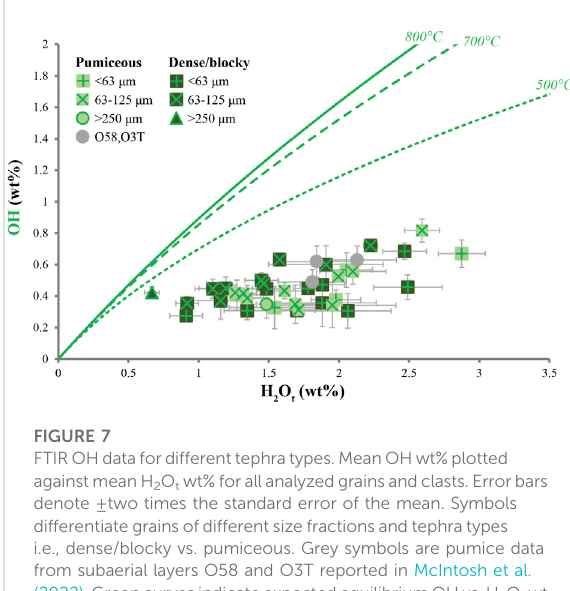
FIGURE 7 FTIROHdatafordifferenttephratypes.MeanOHwt%plotted againstmeanH 2 O t wt%forallanalyzedgrainsandclasts.Errorbars denote ±two times the standard error of the mean. Symbols differentiategrains ofdifferentsize fractions and tephratypes i.e., dense/blocky vs. pumiceous. Grey symbols are pumice data from subaerial layers O58 and O3T reported in McIntosh et al. (2022).GreencurvesindicateexpectedequilibriumOHvs.H Behrens,